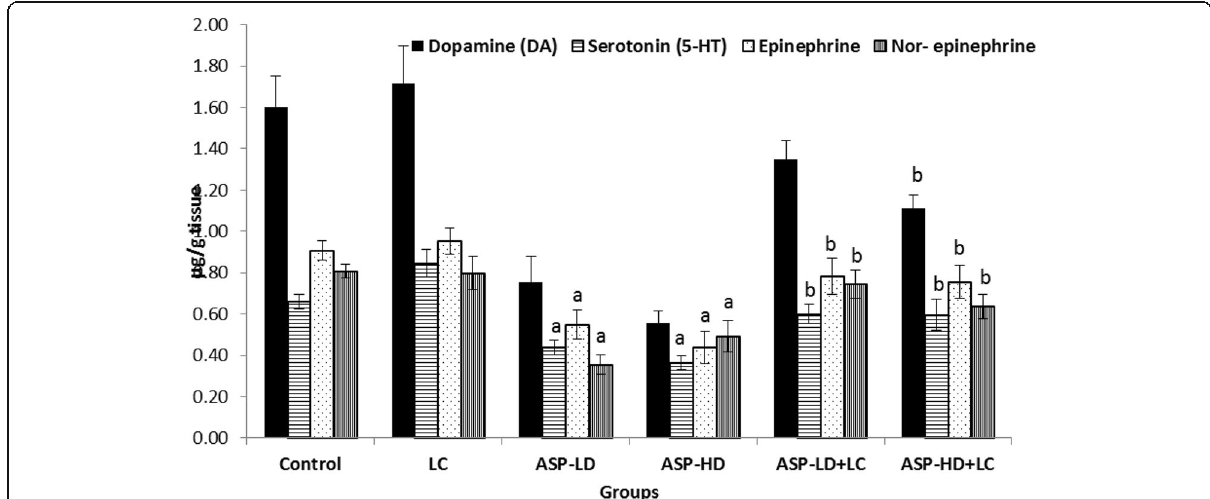
Fig. 2: Effect of L -carnitine on some neurotransmitter in the brain of male rats treated with aspartame. Values are expressed as mean ± SE, n = 8. The value of the significant was represented at the top of the column. a Significant difference as compared to control, and b significant difference as compared to its relative group of ASP ( P ≤ 0.05).